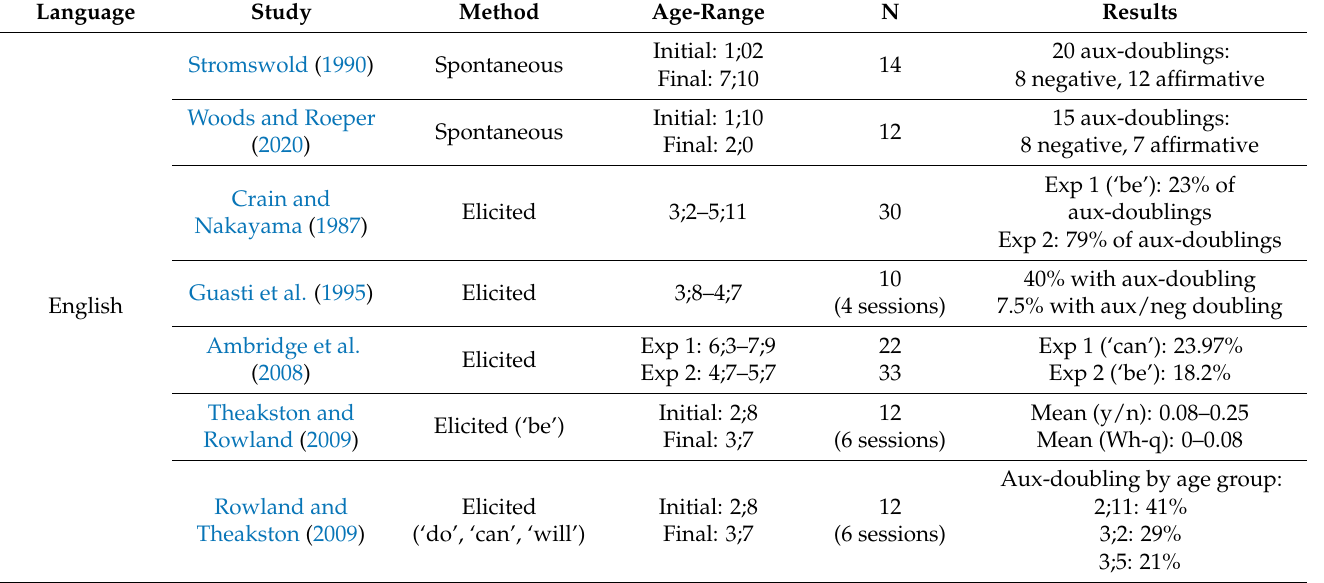
Table A1. Data on